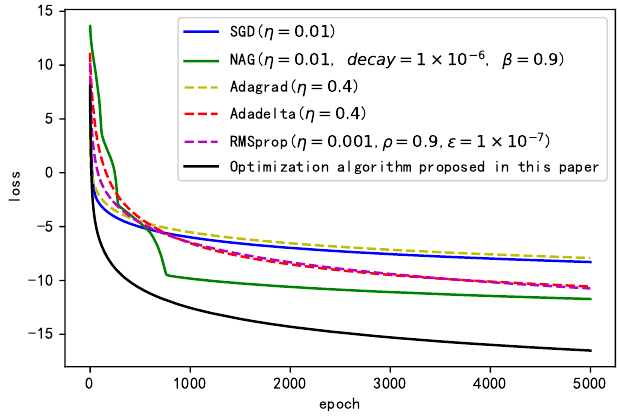
Figure 5. Learning curves of different optimization